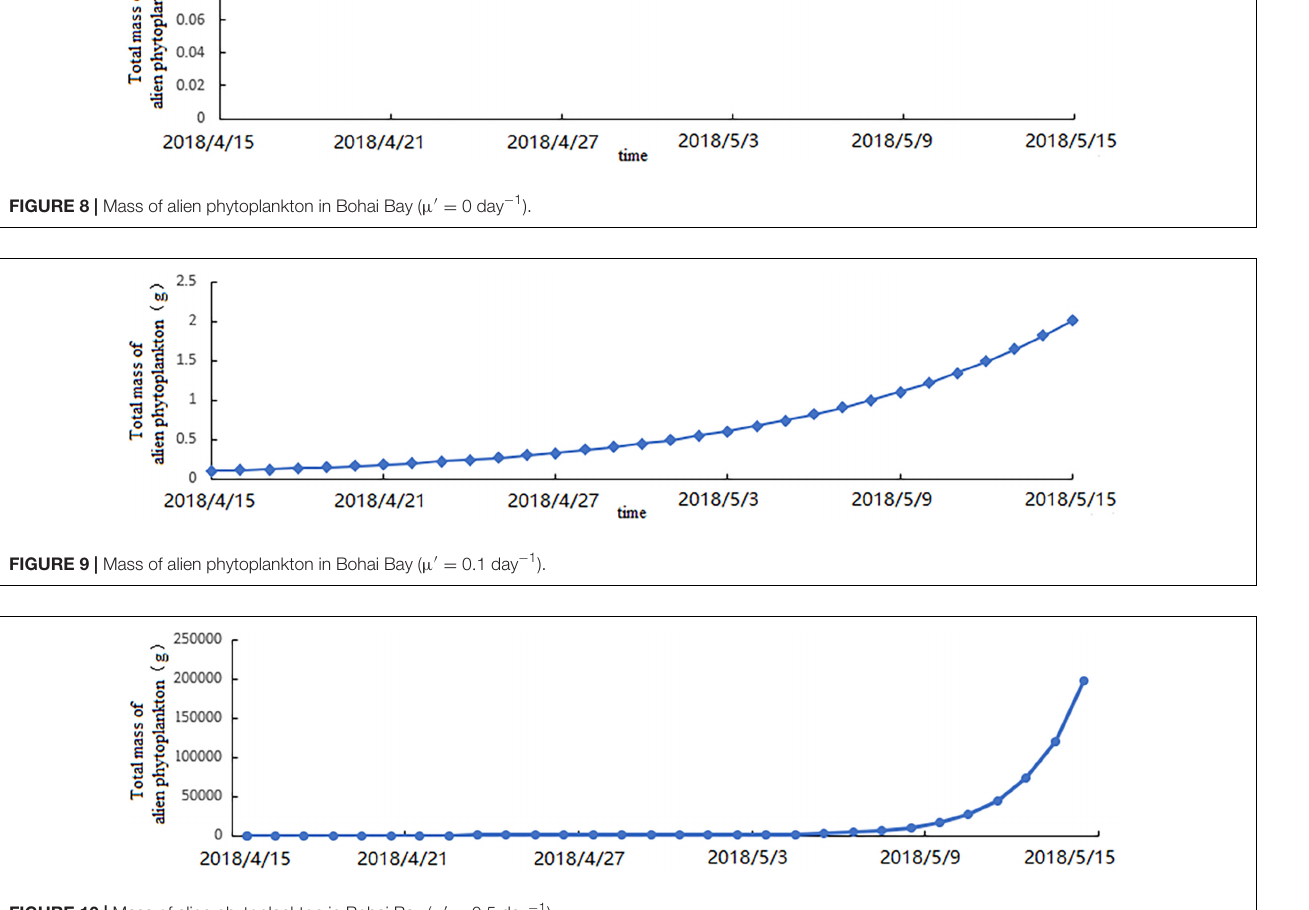
FIGURE 10 | Mass of alien phytoplankton in Bohai Bay ( µ (cid:48) = 0 . 5 day − 1